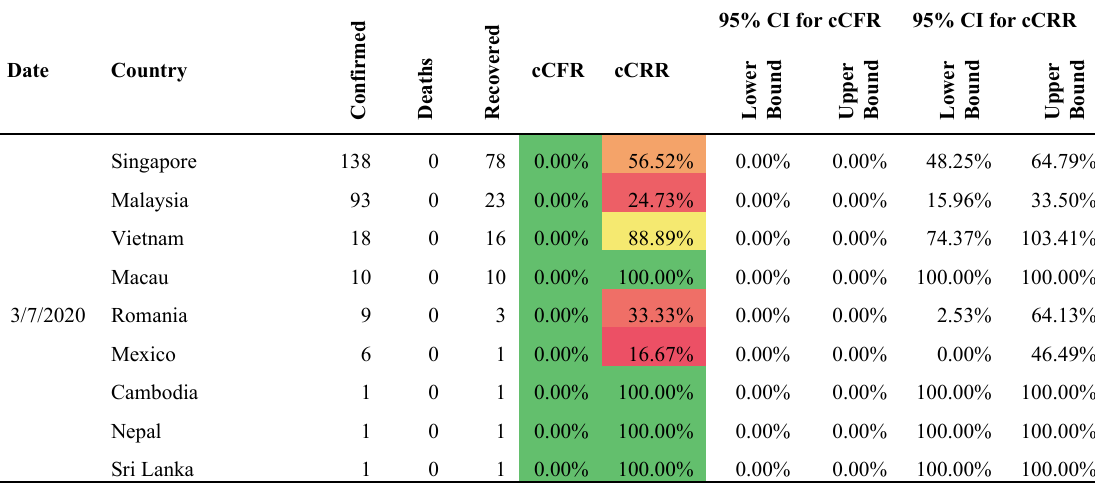
Data for the countries with low cCFR and high